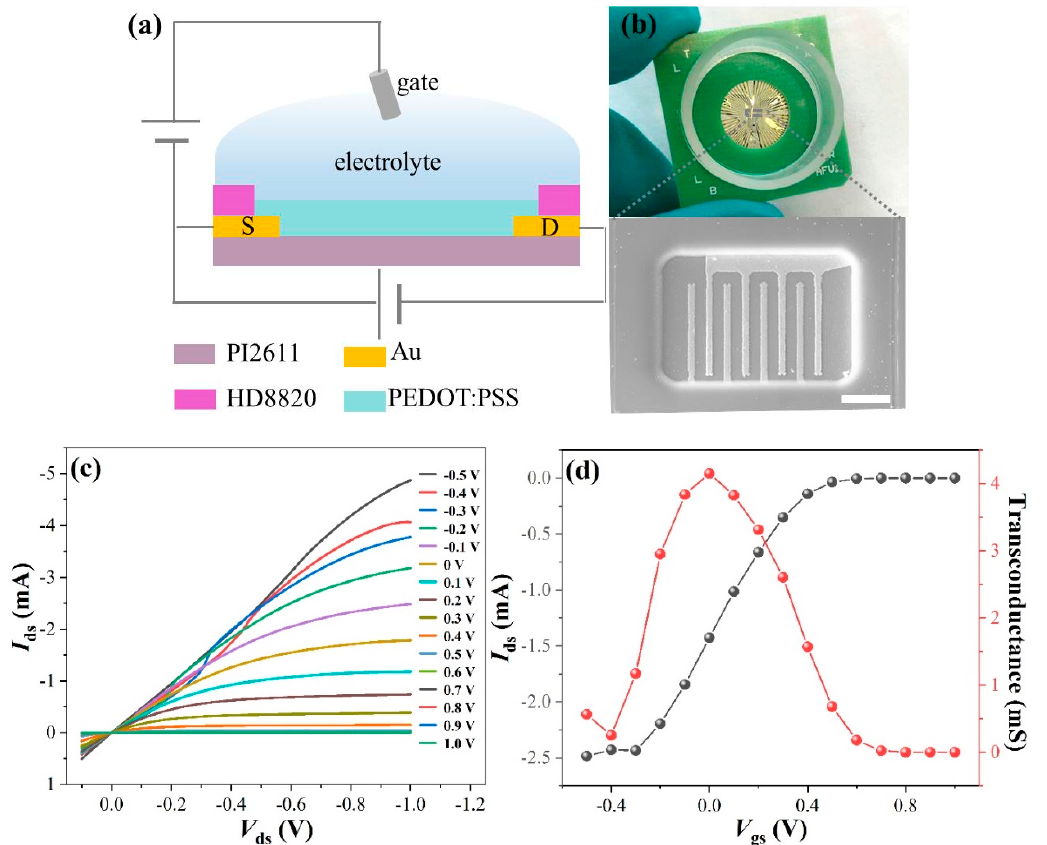
Figure 3. ( a ) Schematic configuration of organic electrochemical transistors (OECTs) embedded in a flexible substrate polyimide. ( b ) Digital photograph of the encapsulated flexible device. The SEM image shows a magnified individual transistor. The scale bar is 10 μ m. ( c ) The output characteristics